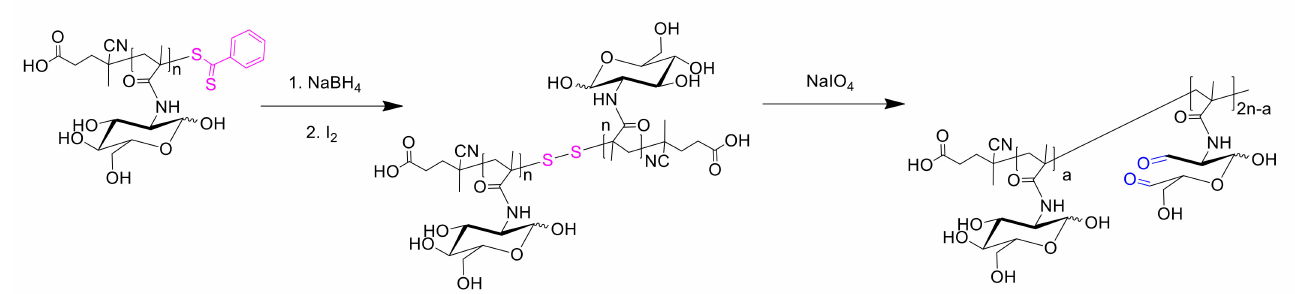
Figure 3. Scheme of synthesis of oxidized